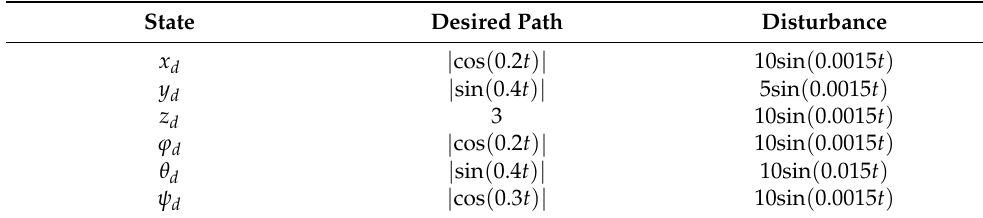
Table 2. Desired path and disturbances.